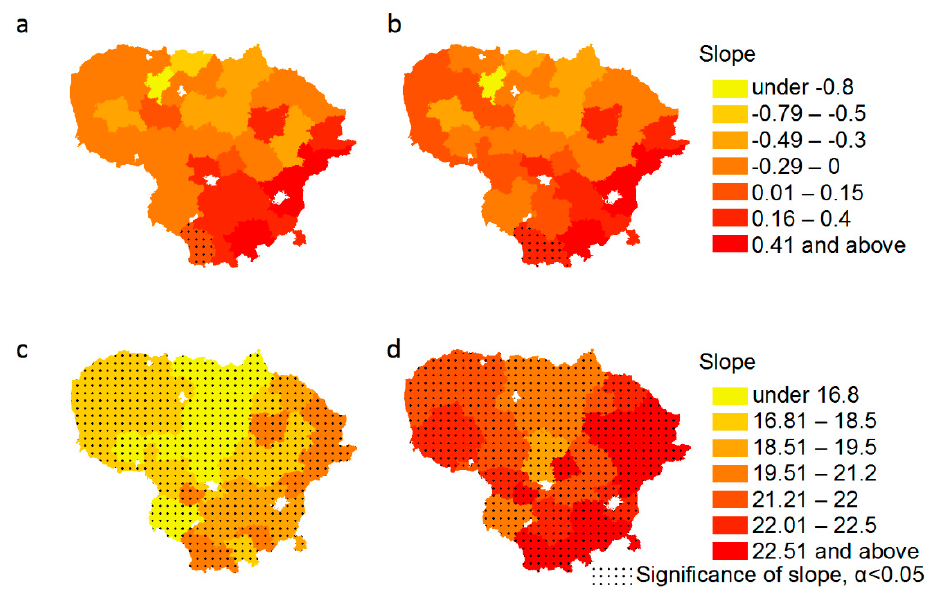
Figure 9. Pattern of climate change effects on harvesting intensity and economic efficiency of forestry in Lithuanian forests during the next 100 years from 2020 to 2120: ( a ) Felling rate, REFERENCE scenario, ( b ) felling rate, EU BIOENERGY scenario, ( c ) profit from forestry activities, REFERENCE scenario, ( d ) profit from forestry activities, EU BIOENERGY